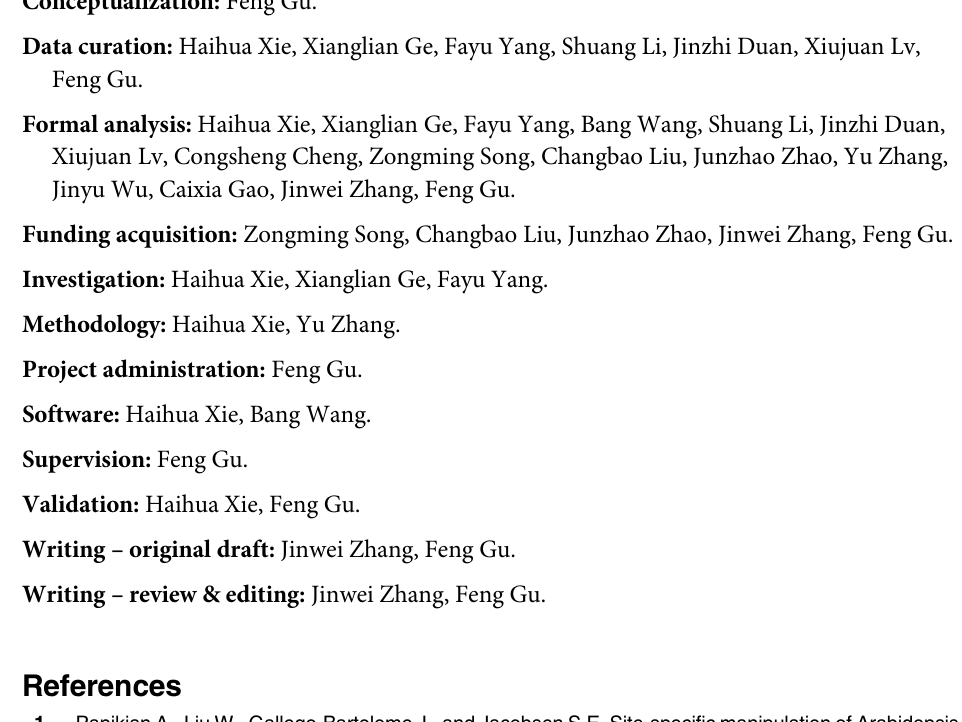
S3 Table. Mutagenesis rate of library A using Sanger sequencing. (XLSX) S1 Data. Relative SaCas9 cleavage efficiency by 63 single-mutated and one perfect-matched sgRNA each for four EGFP target